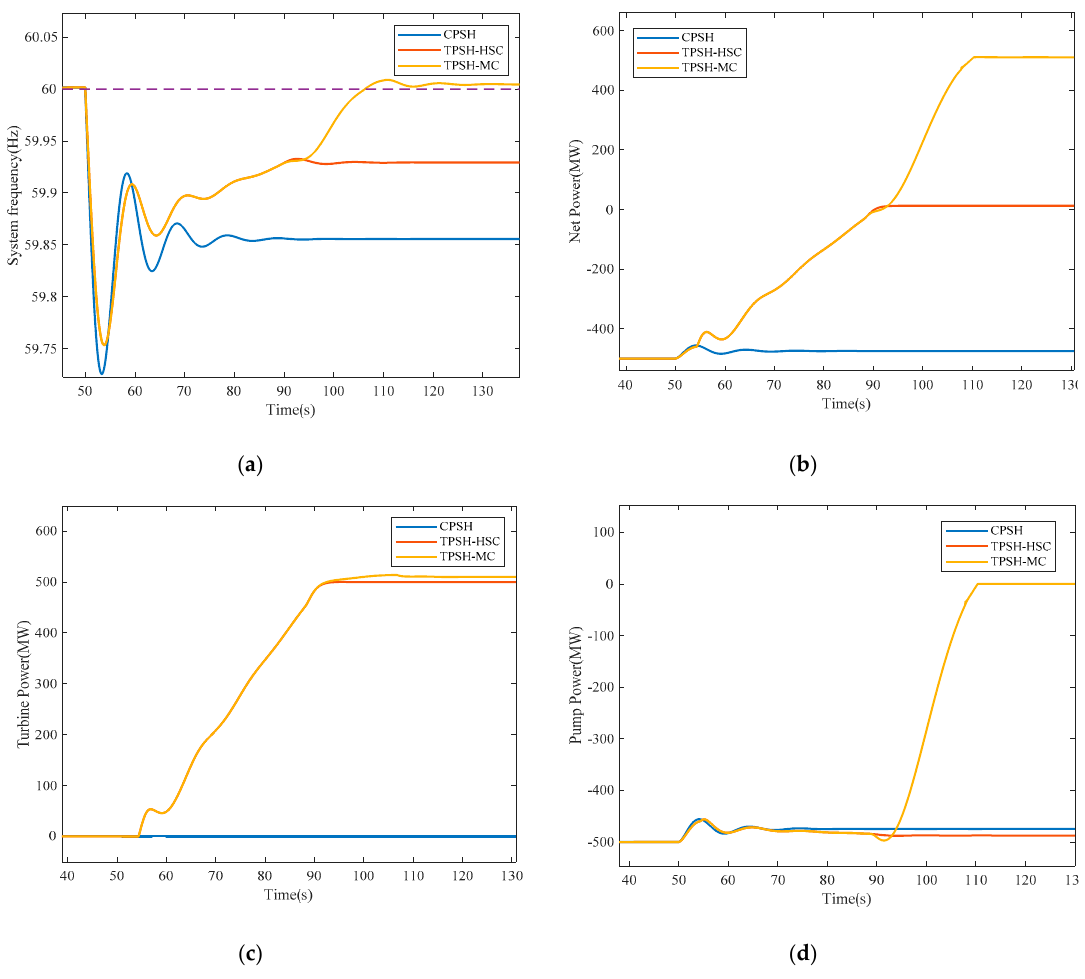
Figure 7. Comparison of CPSH, TPSH in HSC-mode (TPSH-HSC), and TPSH with HSC and mode change capability (TPSH-MC): ( a ) System frequency response; ( b ) net power production or consumption; ( c ) turbine power; and ( d ) pump power without PV.